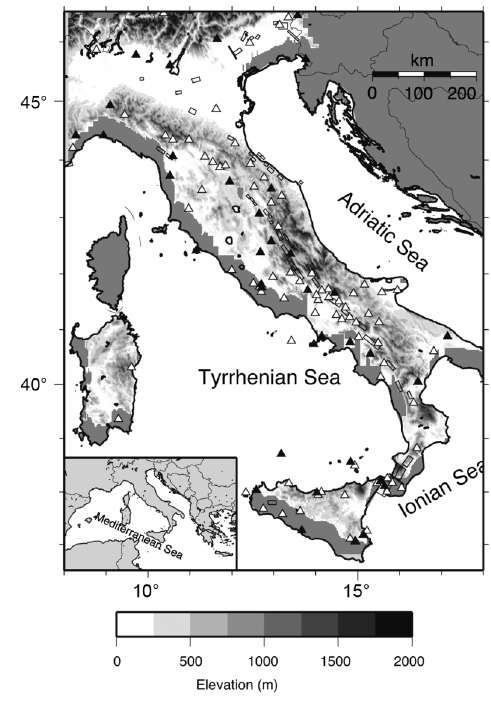
Fig. 1. The Italian Telemetered Seismic Network at the beginning of year 1985 (black triangles) and at the end of year 2002 (black and white triangles). Boxes represent potential seismogenic sources for M > 5.5 earthquakes according to Valensise and Pan- tosti